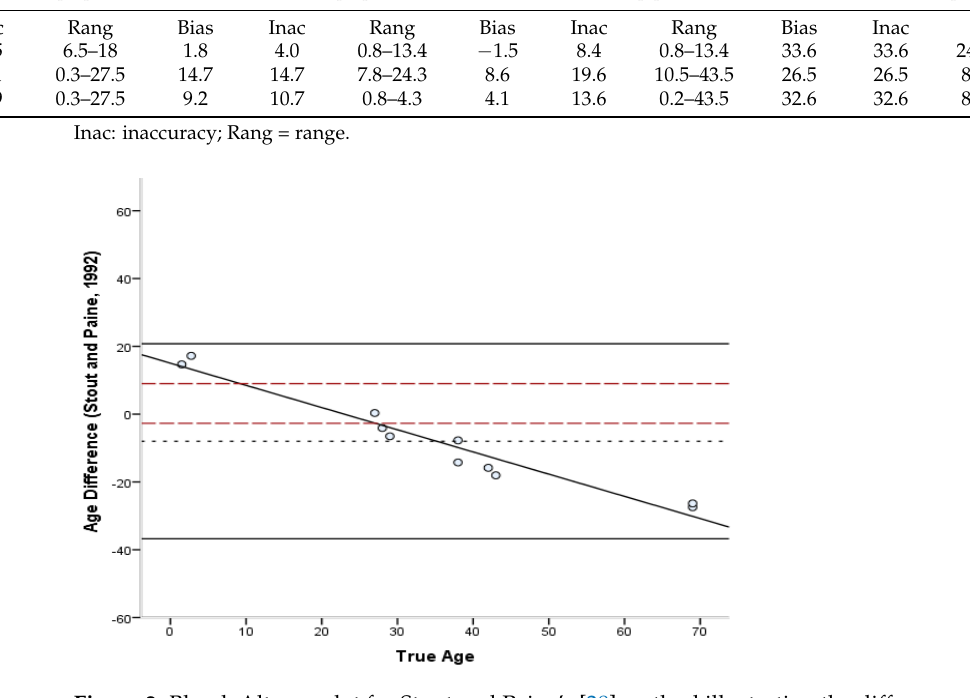
Figure 2. Bland –Altman plot for Stout and Paine’s [28] method illustrating the differences between known and estimated ages for the ribs against the known age. Depicted are 95% limits of agreement (black horizontal lines), mean difference/bias (black dotted line), best fit lines and 95% confidence intervals of the SEE for each method (dashed lines). R 2 of the best fit line: 0.947.